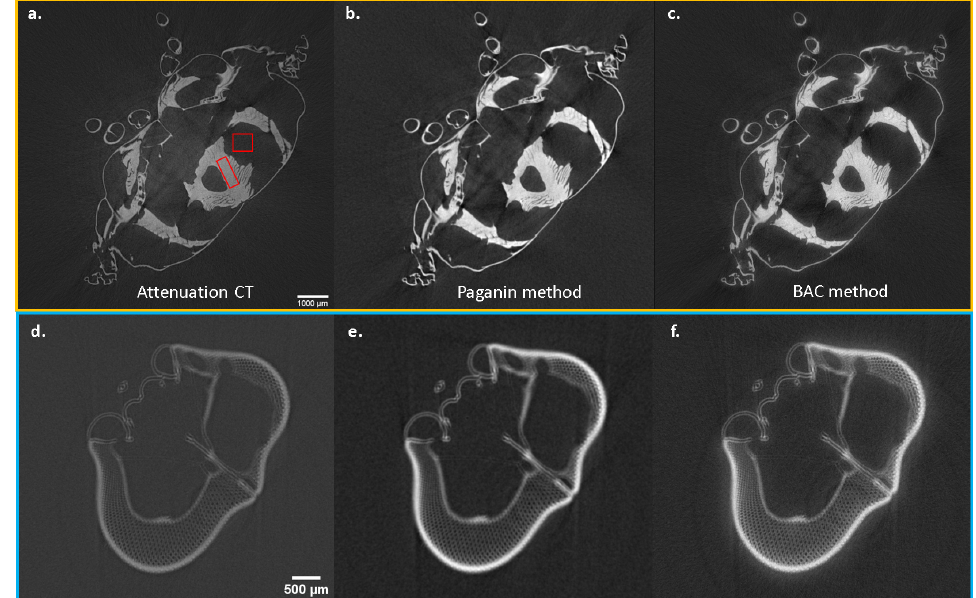
Figure 5. Comparison of the attenuation-based micro-CT images of the horse fly ( a , d ), with the propagation-based images reconstructed by using Paganin’s phase retrieval method, ( b , e ), based on Equation (6), and with the BAC method based on Equations (3) and (4), ( c , f ). The upper images show a horizontal slice at the region of the flight muscles (see orange line in Figure 4a), whereas the lower images are taken at the level of the compound eye showing clearly the individual ommatidia (see the blue line in Figure 4a). The areas circumvented in red indicate the ROIs used for determining the CNR values between sample material and air (see Table 1).